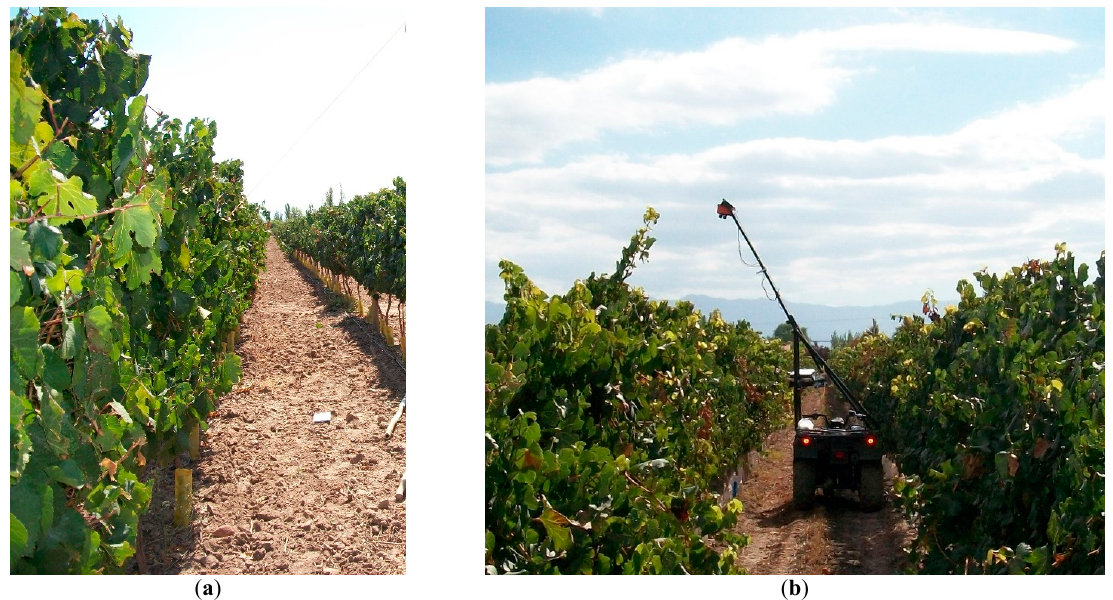
Figure 1. ( a ) Example of a vertically shoot positioned (VSP) vineyard (cv. Malbec); ( b ) Tetracam ADC multispectral camera mounted on a boom on a quadricycle in preparation for a nadir-viewing capture on the canopy in a VSP vineyard.